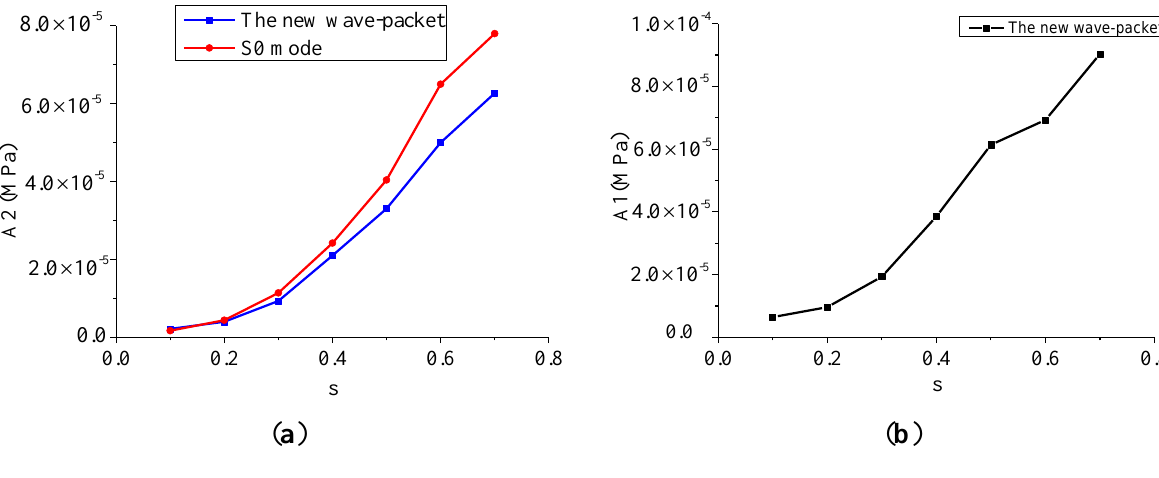
Figure 14. ( a ) Variation of amplitude ratio with the micro-crack length severity for the S0 mode wave-packet. A2/A1 represents the amplitude ratio; s represents the micro-crack length severity. ( b ) The variation of amplitude ratio with micro-crack length severity for the new wave-packet. A2/A1 represents the amplitude ratio; s represents the micro-crack length